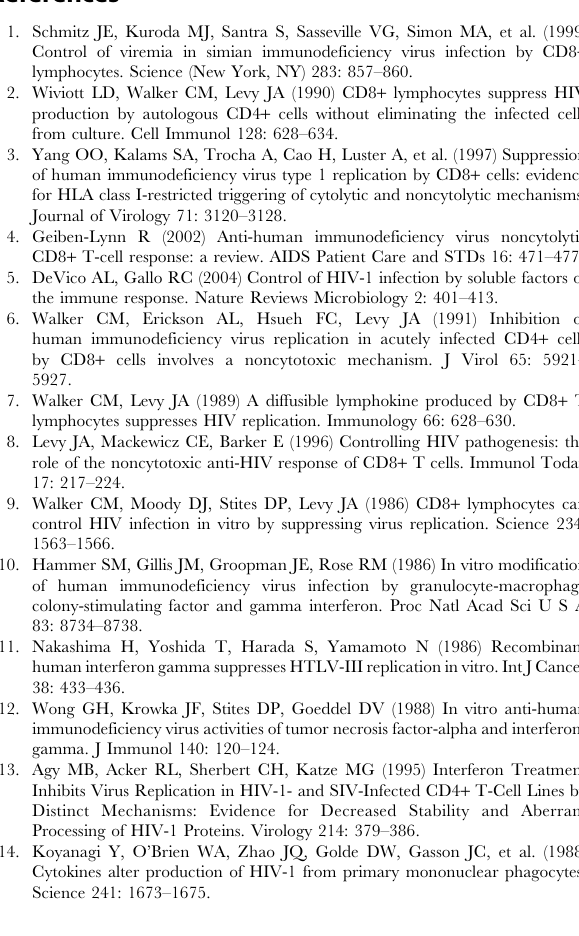
Figure S11. Immune control exerted by a non-lytic response that reduces virion production. Equivalence of non-lytic models in chronic infection. Supplementary